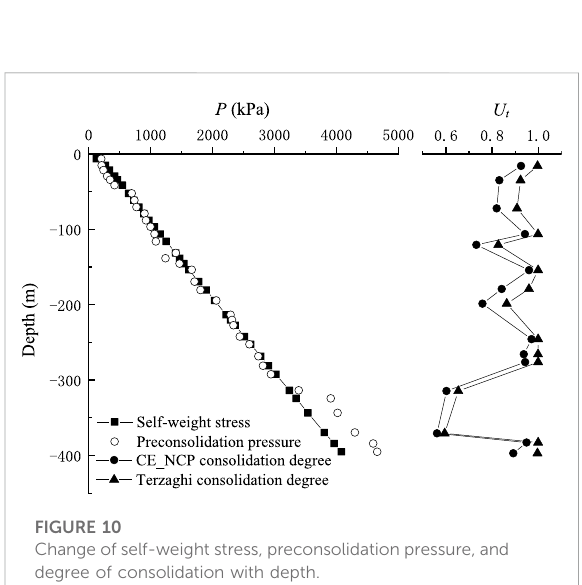
FIGURE 10 Change of self-weight stress, preconsolidation pressure, and degree of consolidation with